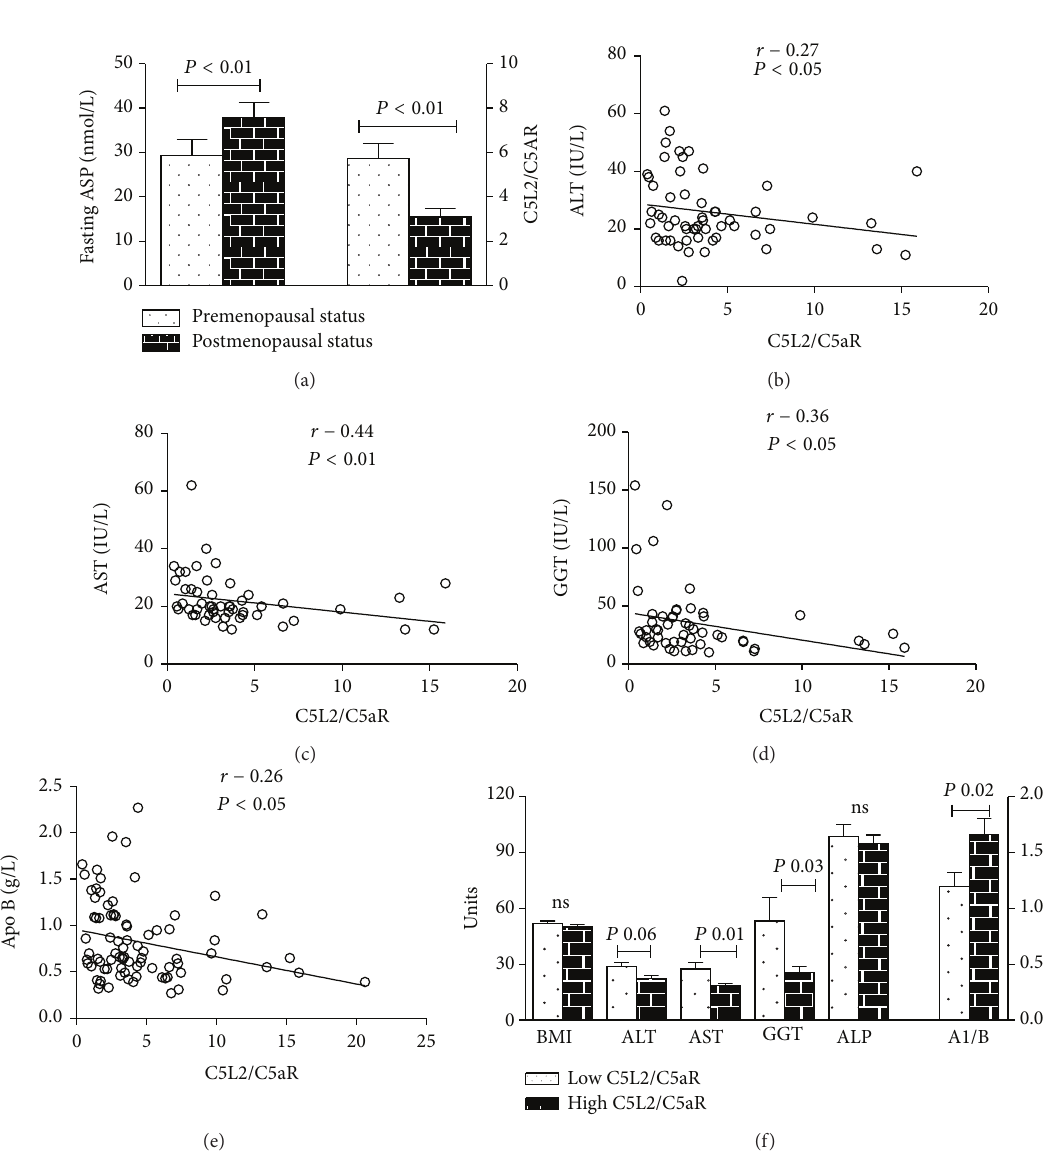
Figure 3: Association of hepatic C5L2/C5aR mRNA ratio with menopausal status and metabolic profile. mRNA was extracted from liver biopsies and reverse-transcribed to cDNA and gene expression was evaluated by RT-PCR with the indicated primers with all results expressed relative to GAPDH using the ΔΔ Ct method as described in detail in Section 2. (a) Comparison of hepatic C5L2/C5aR mRNA expression ratio and plasma ASP levels in premenopausal and postmenopausal groups. ASP values were log transformed for statistical analysis. ((b)–(d)) LinearplotcorrelationofliverenzymesALT,AST,andGGTwithC5L2/C5aRmRNAratio.(e)LinearplotcorrelationofApoBandC5L2/C5aR mRNA ratio. (f) Comparison of preoperative BMI (kg/m 2 ) and fasting liver enzymes (IU/L) (left 𝑦 -axis) and ApoA1/B ratio (right 𝑦 -axis) before bariatric surgery in subjects separated based on low versus high C5L2/C5aR mRNA ratio, compared by unpaired Student’s 𝑡